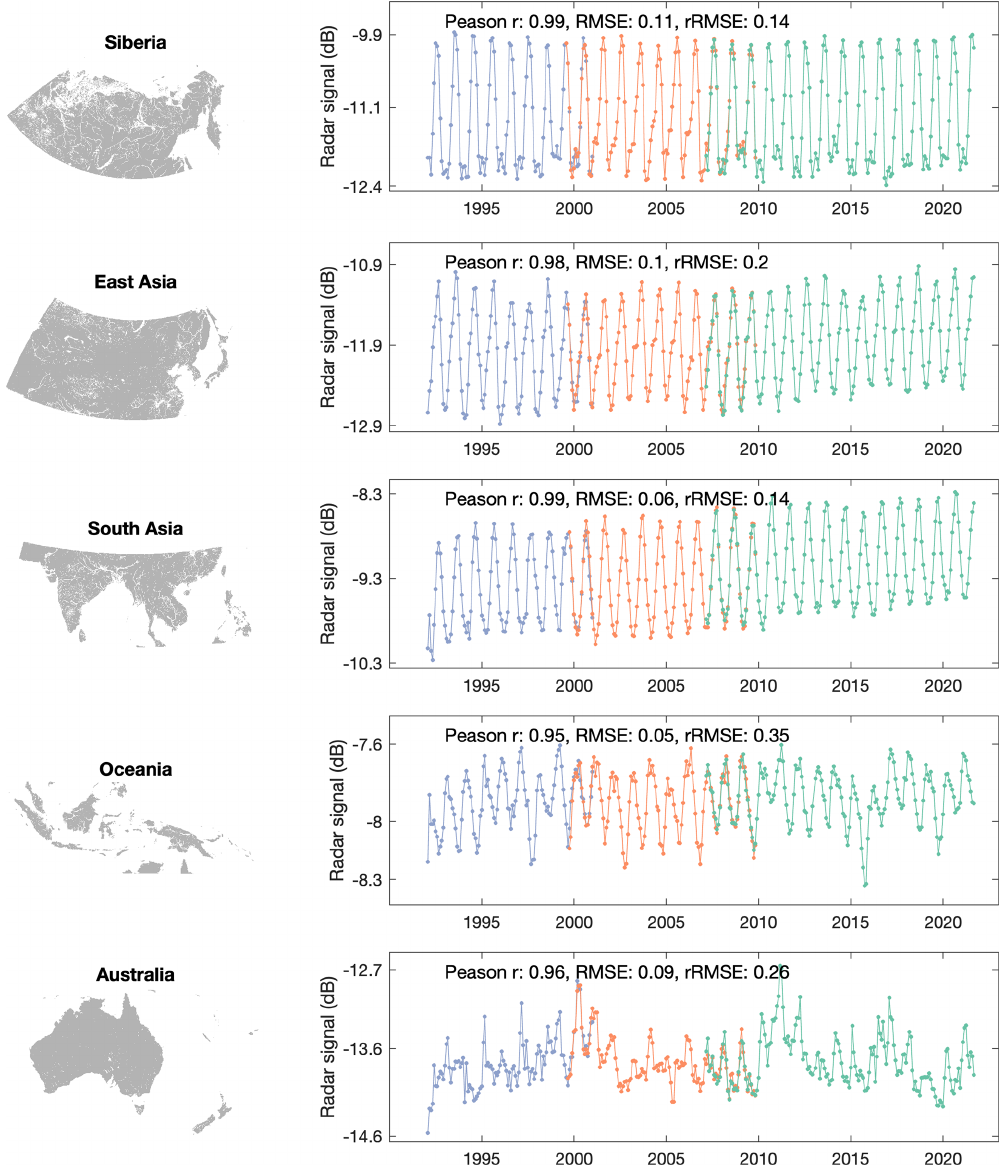
Figure 5. Time series and quality assessment of the merged LHScat radar time series at the regional level. Each row shows one region. Inside each row, the map in the left panel shows the location of the region. The Lambert equal-area projection is used in the map. The line plot in the right panel shows the merged radar time series, averaged across pixels and coloured according to sensors. The Pearson r (unitless), RMSE (dB), and rRMSE (unitless) labelled in the panel were calculated using the C-band and the corrected Ku-band signals in the overlapping years (1999–2001 and 2007–2009) as indicators of the data-merging